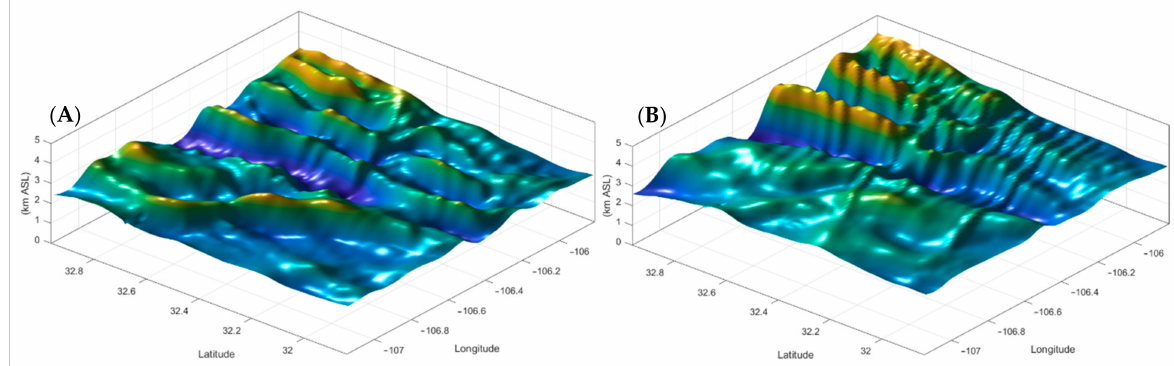
Figure 11. WRF BL depth, 17 April 2018. ( A ) 1700 UTC, clear modulation of the BL by lee waves. ( B ) 2100 UTC, longitudinal perturbations in the BL where the LRS interact with the